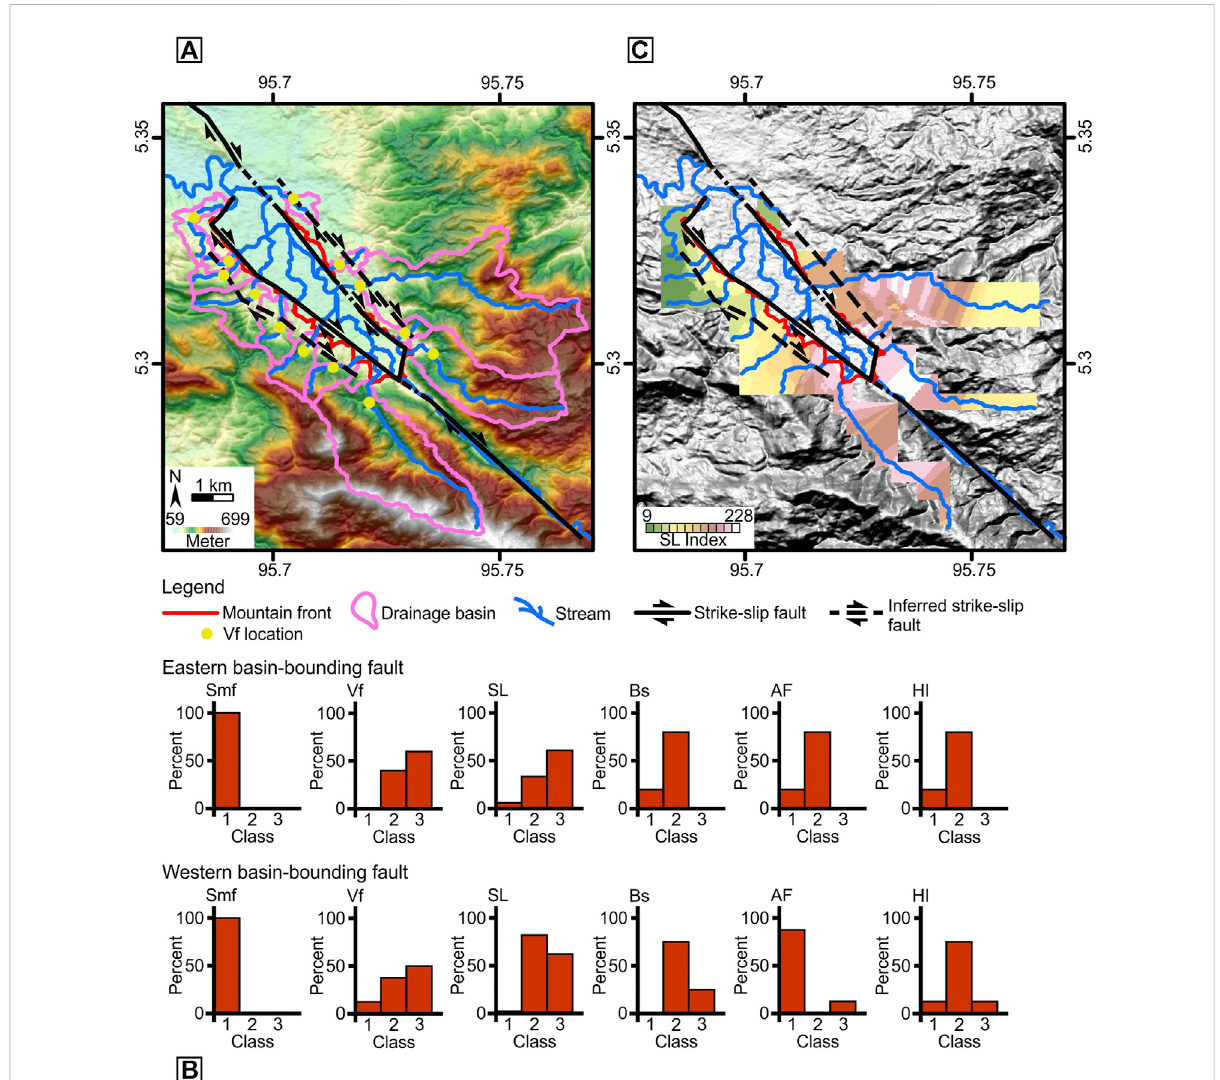
FIGURE 6 The Lam Kubu Basin: (A) the mountain fronts, faults, and drainage basins, (B) classi fi cation of geomorphic indices, and (C) stream length- gradient